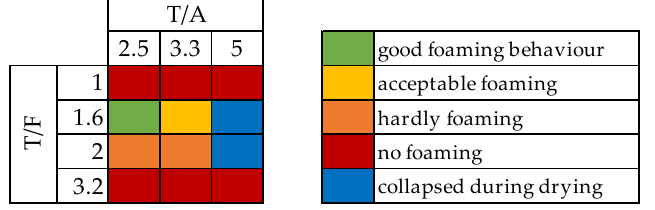
Figure 2. Heatmap of foaming behavior depending on T/F and T/A ratio using 4% SDS. For all surfactants and concentrations, results were quite similar. The only difference was that for SDS at a T/A ratio of 5 the foams did not harden at all, and a liquid was left in the oven. Meanwhile, for TWEEN at a T/A ratio of 5, a foam was obtained, yet only after more compact and denser than the